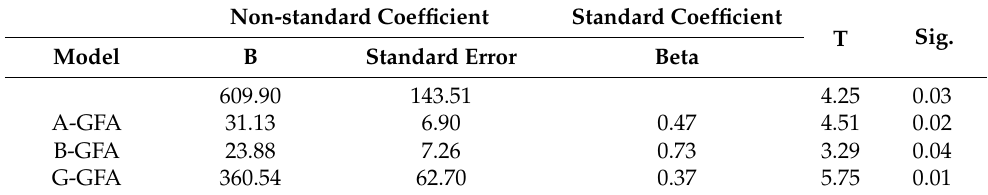
Table 8. Corresponding coefficients.